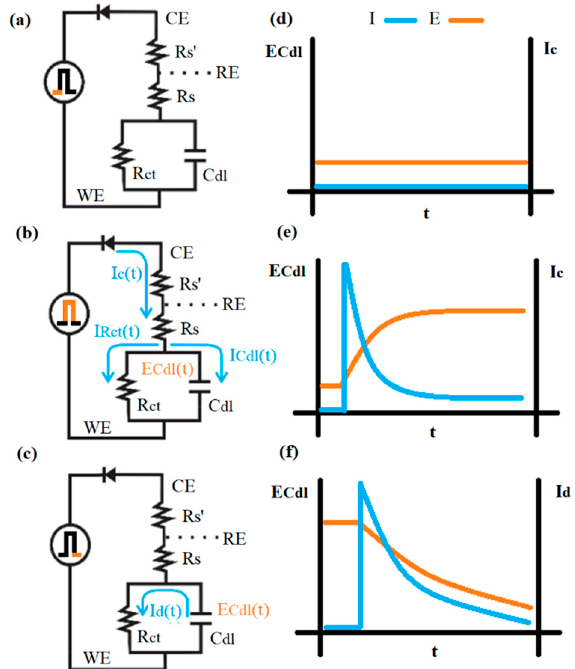
Figure 2. Proposed methodology to determine the potential relaxation: ( a , d ) equilibrium double layer; ( b , e ) double-layer charging; ( c , f ) double-layer discharging.